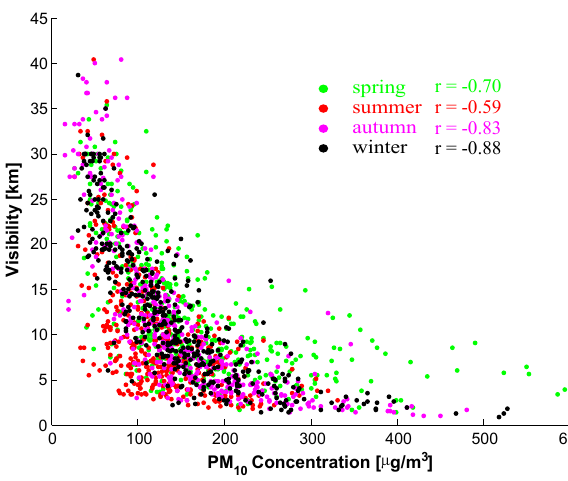
Fig. 5. Daily mean visibility of BCIA vs. daily mean PM 10 con- centration in Beijing from 2003 to 2007 using the 19 observing sta- tions. The correlation index between visibility and ln(PM 10 con- centration) for four seasons is shown as the variable “ r ”.